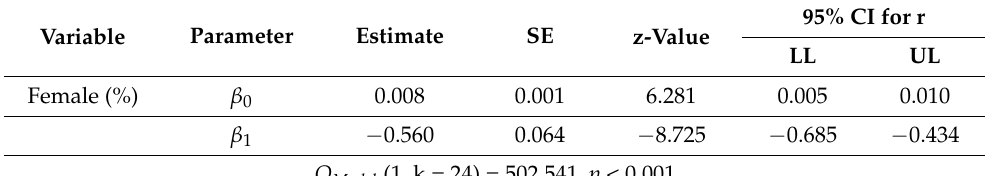
Table 3. Meta-regression analysis of female%.